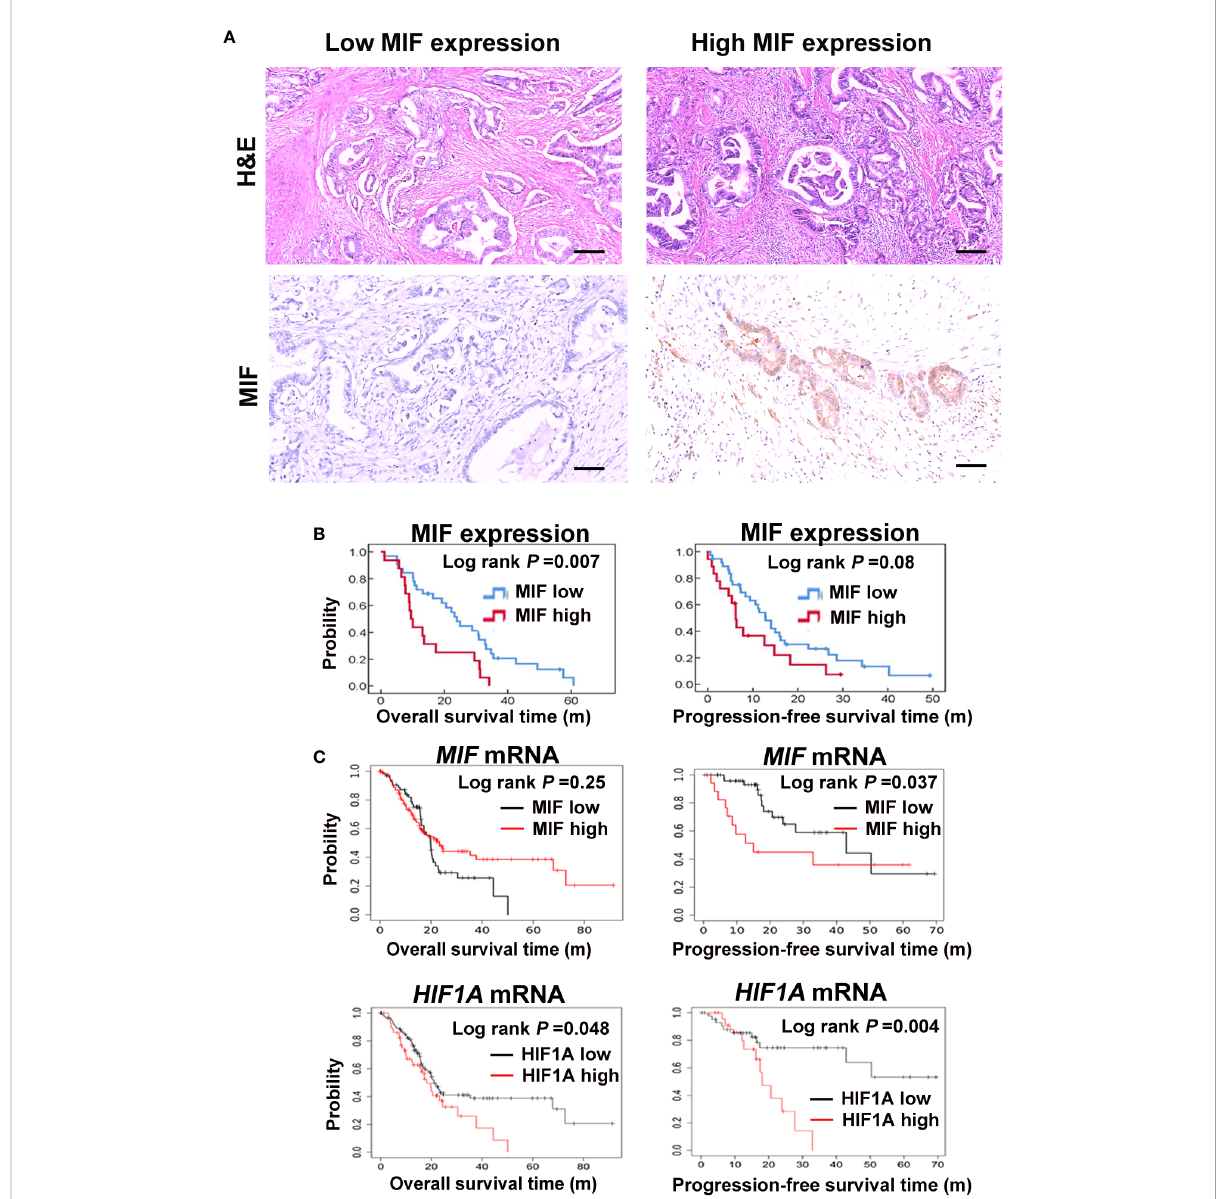
FIGURE 1 Elevated MIF expression correlates with a poor prognosis in PDAC patients (A) Pathological and histological assessment of 84 human PDAC sections, including haematoxylin eosin staining (H&E) and expression of MIF by immunohistochemistry staining. Representative images of MIF immunostaining with low and high intensity. Scale bars, 100 m m. (B) Kaplan − Meier plots show the correlations between MIF mRNA expression and the OS/PFS of 84 PDAC patients. (C) Survival curves show the relationships between MIF or HIF1A mRNA expression and OS/PFS of 177 PDAC patients from the KM-Plotter